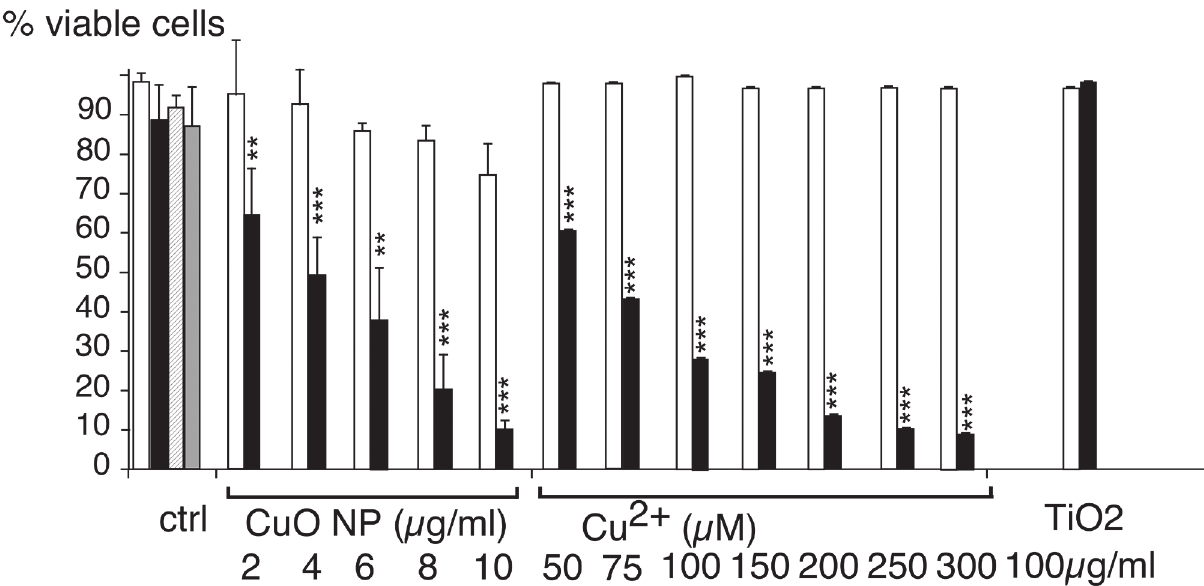
Fig 8. Interplay between DOPA and copper in cell survival. J774 cells were first treated with 100 μ M DOPA for 6 hours (black bars) or with vehicle (white bars). Copper oxide nanoparticles or copper ion or titanium dioxide nanoparticles were then added at the indicated concentrations for the remaining 18 hours prior to viability measurement. Hatched bar: cells treated with 100 μ M oxidized DOPA. Grey bar cells treated with PVP only (4 μ g/ml). Experiments were carried out in quadruplicate. Statistical confidence (Student T-test) is indicated as follows: * : p (cid:1) 0.05; ** p (cid:1) 0.01; *** p (cid:1) 0.0011.